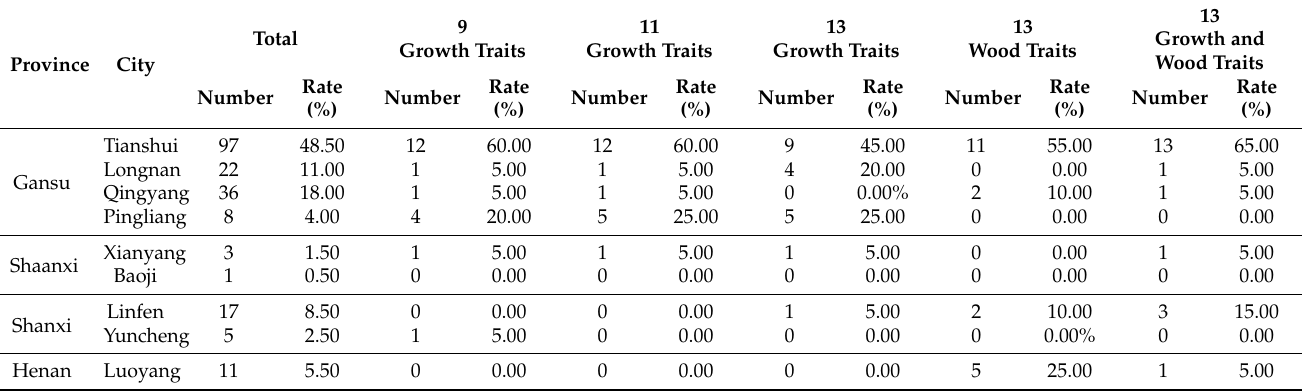
Table 3. Selection rate of excellent C. fargesii clones in various